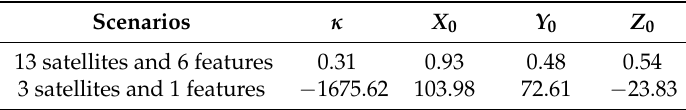
Actual error of camera state estimation by extended integration model, units are [degree, m, m,